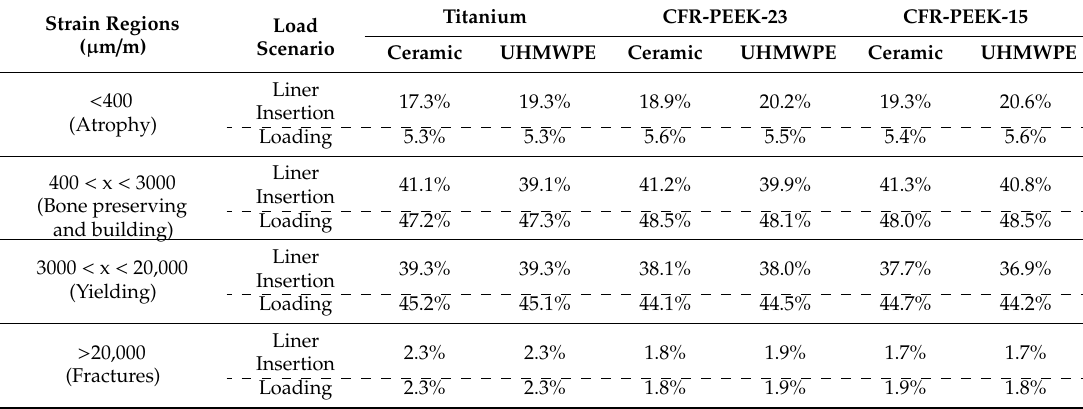
Table 5. Comparison of the percentage of analyzed nodes, categorized into the different strain regions after liner insertion and after loading in dependency of the acetabular shell and liner material.